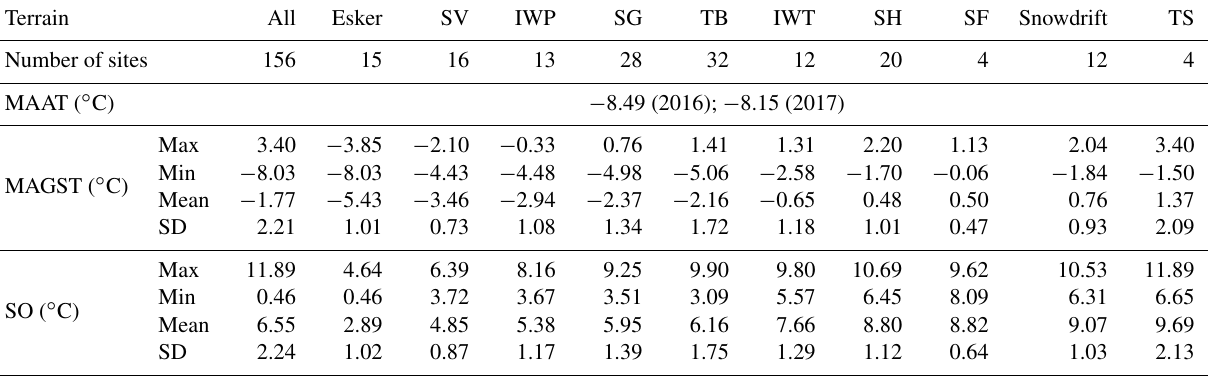
Table 4. Summary of temperatures in the 10 terrain types. Terrain